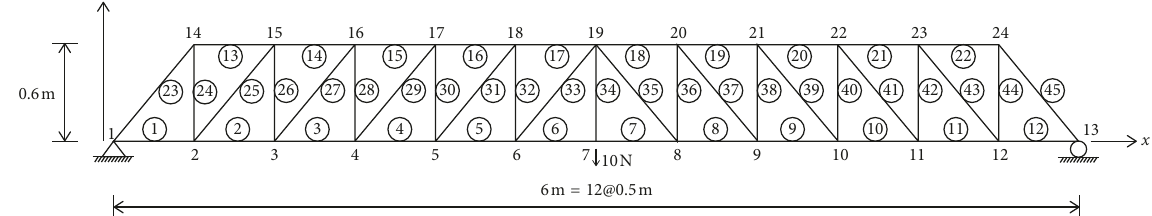
Figure 6: Numerical model of the truss structure for damage detection. at the lower and upper chords do not provide any damage 2.2.1. Complete Measurement Data. Figure 7 illustrates the information without any additional considerations, such as numerical results calculated from the complete noise-free flexural curvature. Figure 7(b) represents the stiffness var- measurement data before and after the damage. Figure 7(a) iation rates calculated by equation (6), respectively. It is represents the horizontal and vertical displacement varia- observed that abrupt stiffness variations are located at the tions before and after the damage. The plots display the damaged elements, and the variation rate coincides with the abrupt changes at the node to move from the lower to the damage degree of 20%. The application indicates that the upper chords. The damage positions at the element represent damage can be clearly detected if accurate information is the abrupt displacement variation owing to the stiffness provided on the completely measured displacements. deterioration. However, the continuous displacement plots